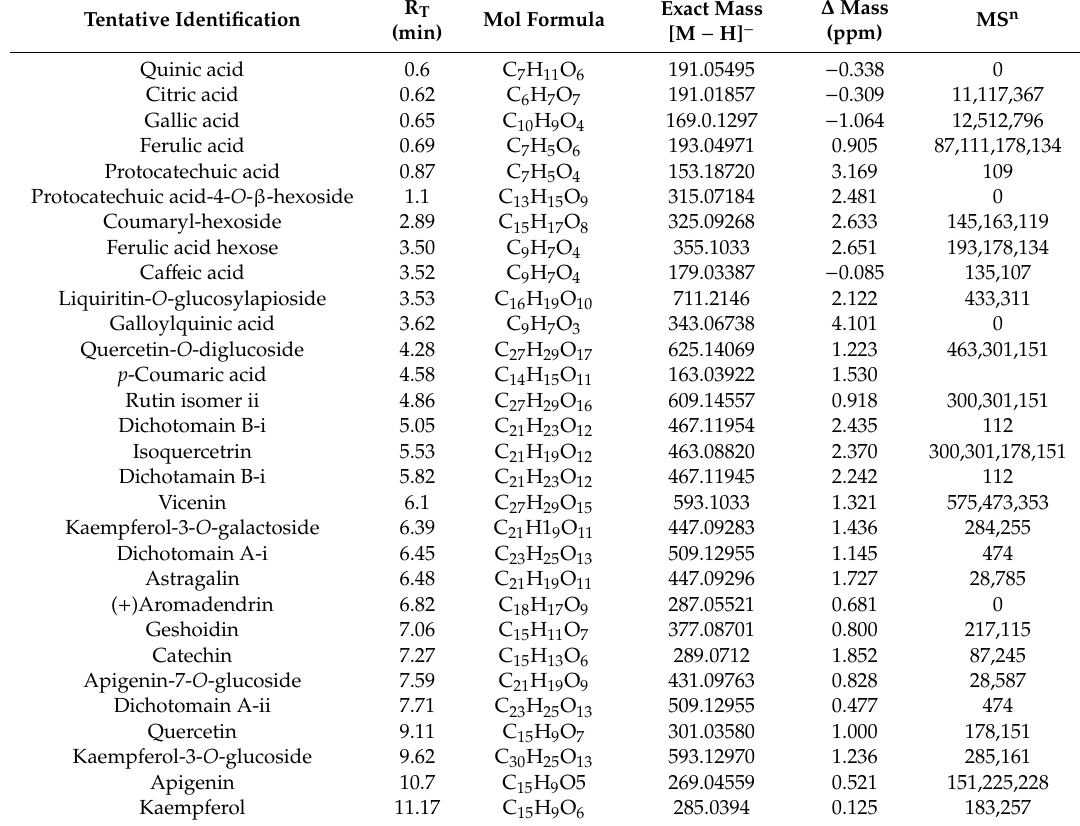
Table 3. Phytochemical compounds detected and characterized in MEDL using UHPLC-ESI-HRMS in negative ion